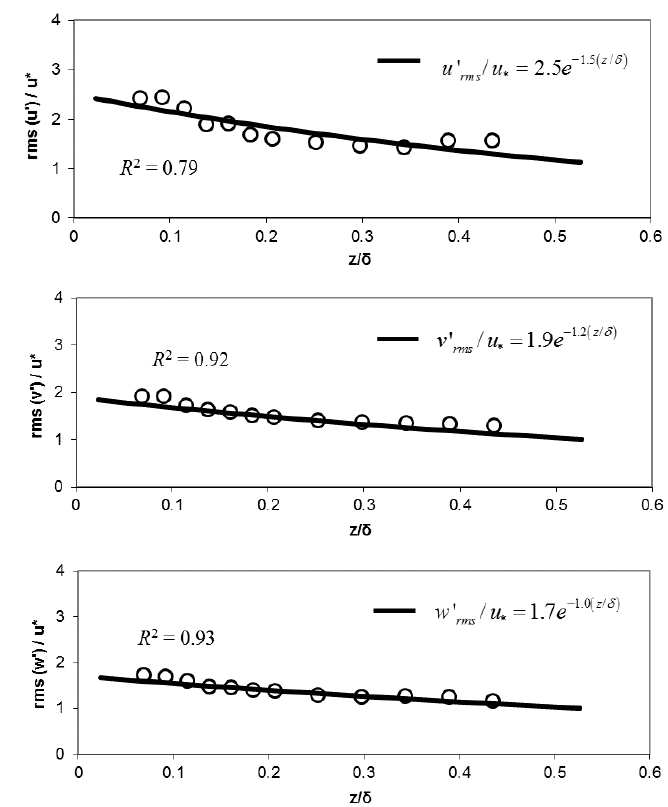
Figure 5. Measured normalised turbulence intensity profiles for rough bed flow (Test 2).